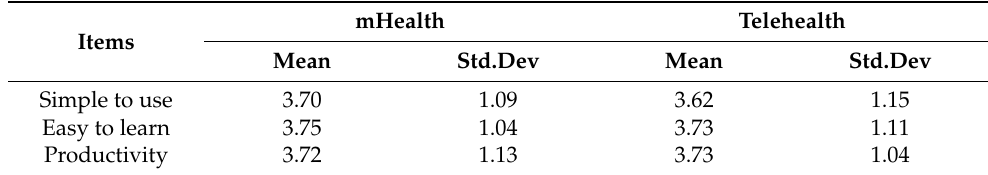
Table 4. Ease of use and learnability of mHealth and Telehealth.